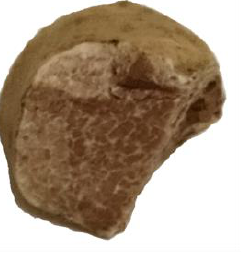
Figure 1. Investigated truffle species, from left to right: Tuber magnatum pico, Tuber melanosporum, Tuber aestivum , and Tuber indicum.